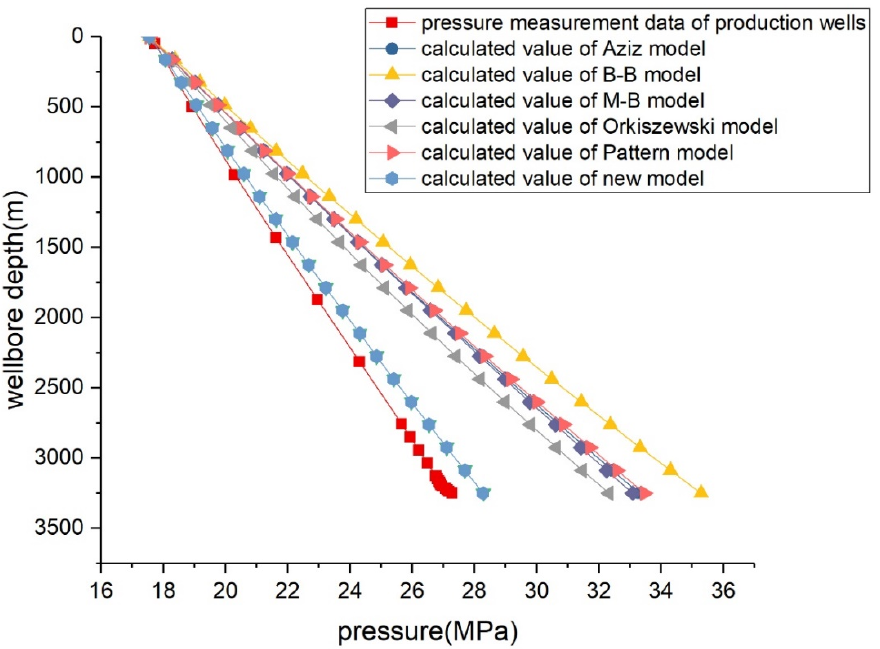
Figure 21. Different pressure calculation methods applied to the No. 1 well of the Donghai gas field.